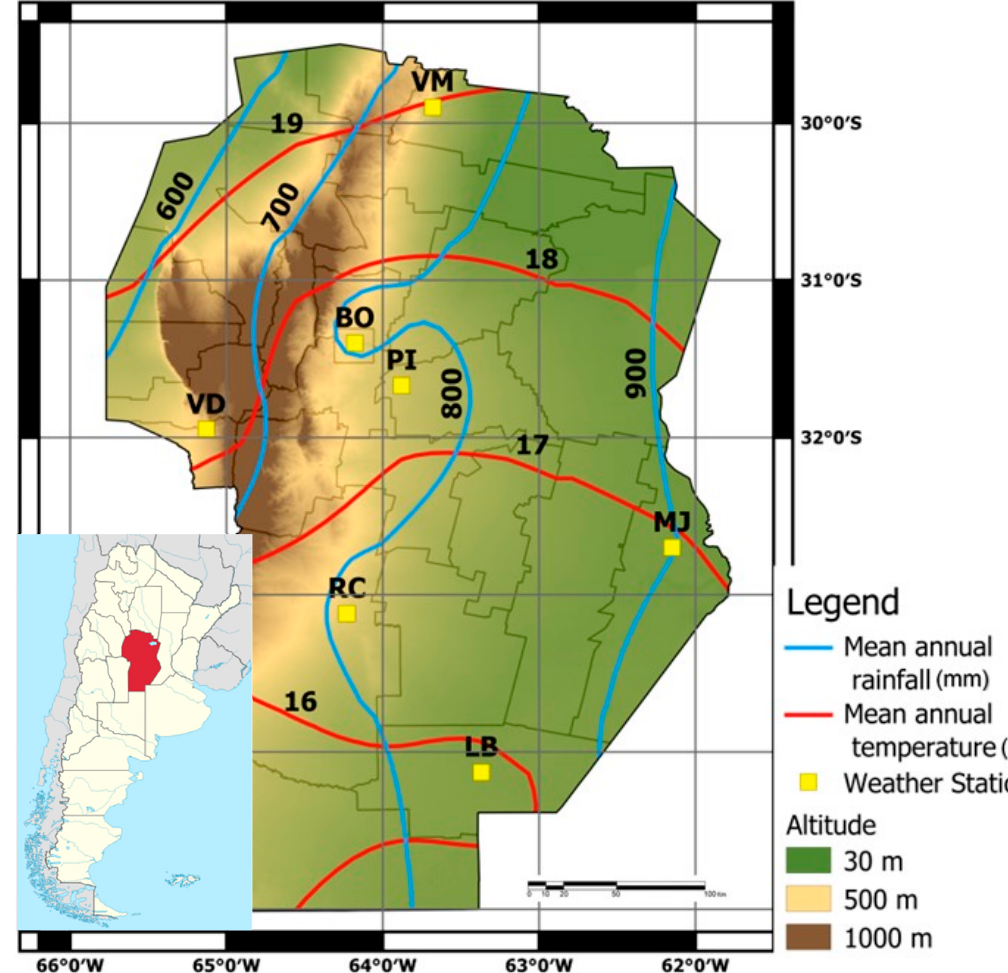
Figure 1. Geographical location of the weather stations in Córdoba Province, Argentina, used in the study: Córdoba Observatorio (BO), Laboulaye Aero (LB), Marcos Juárez Aero (MJ), Pilar Observatorio (PI), Río Cuarto Aero (RC), Villa Dolores Aero (VD), and Villa María de Río Seco (VM).